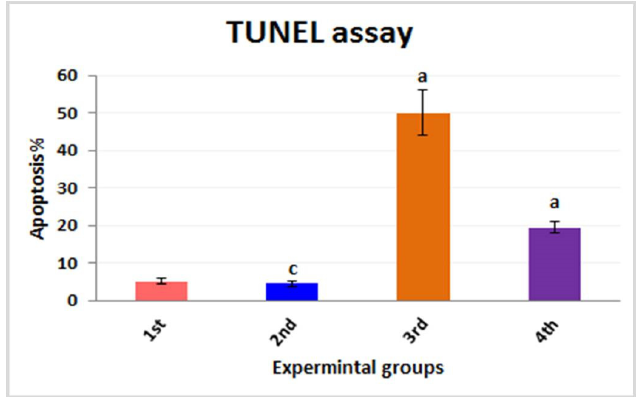
Figure 7. Light explanation microscopy for histochemistry apoptotic cells ( A ) Mouse liver section from the first group displaying no TUNEL-positive apoptotic cells in the healthy tissues of hepato- cytes around the central hepatic vein (CV) (TUNEL, 400×). ( B ) Mouse liver section from the second group showing the normal distribution of normal hepatocytes in the hepatic cord found around the central vein (CV) (TUNEL, 400×). ( C ) The mouse liver section from the third group that detected the distribution of apoptotic cells (red arrows) was displayed in the liver tissues after the mice were exposed to Fe 2 O 3 -nanoparticles; the inflammatory cells were found around the central vein (CV), and vacuolation (asterisks) was observed (TUNEL, 400×). ( D ) Mouse liver section from the fourth group showing a cure in the apoptotic cells (red arrows) within the hepatocytes which were located around the hepatic central veins (CV) and a mild appearance of vacuolation (asterisk) (TUNEL, 400×); this shows the usefulness of using PPE in the improvement of toxicity, which was induced in the morphology of the liver tissues of mice exposed to Fe 2 O 3 -NPs.